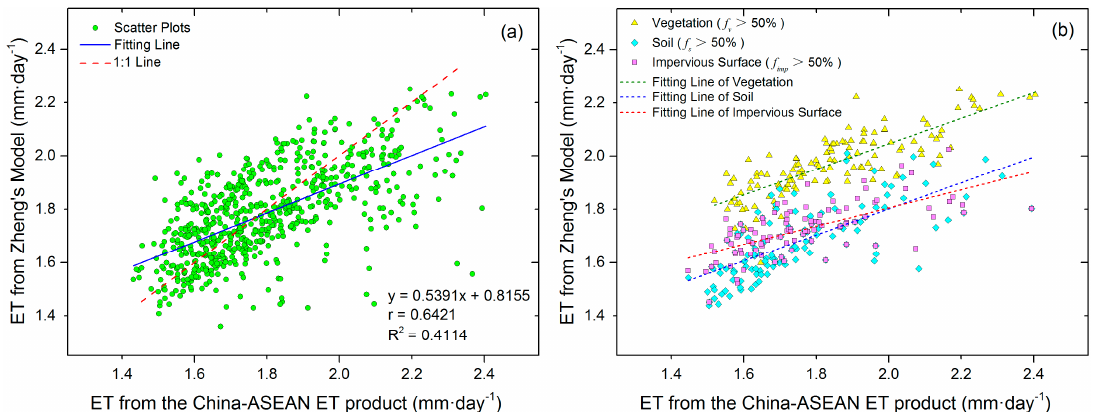
Figure 16. ( a ) Scatter plot of Zheng’s model derived ET against the China–ASEAN ET product, based on the entire 552 sampled points; ( b ) scatter plot of Zheng’s model derived ET against the China–ASEAN ET product, for each land cover (136 sampled points for vegetation, 117 for soil, and 93 for impervious surfaces). Table 9. Linear relationship between the ET estimated from Zheng’s model and the China–ASEAN ET product for each land cover type (vegetation, soil, and impervious surfaces).